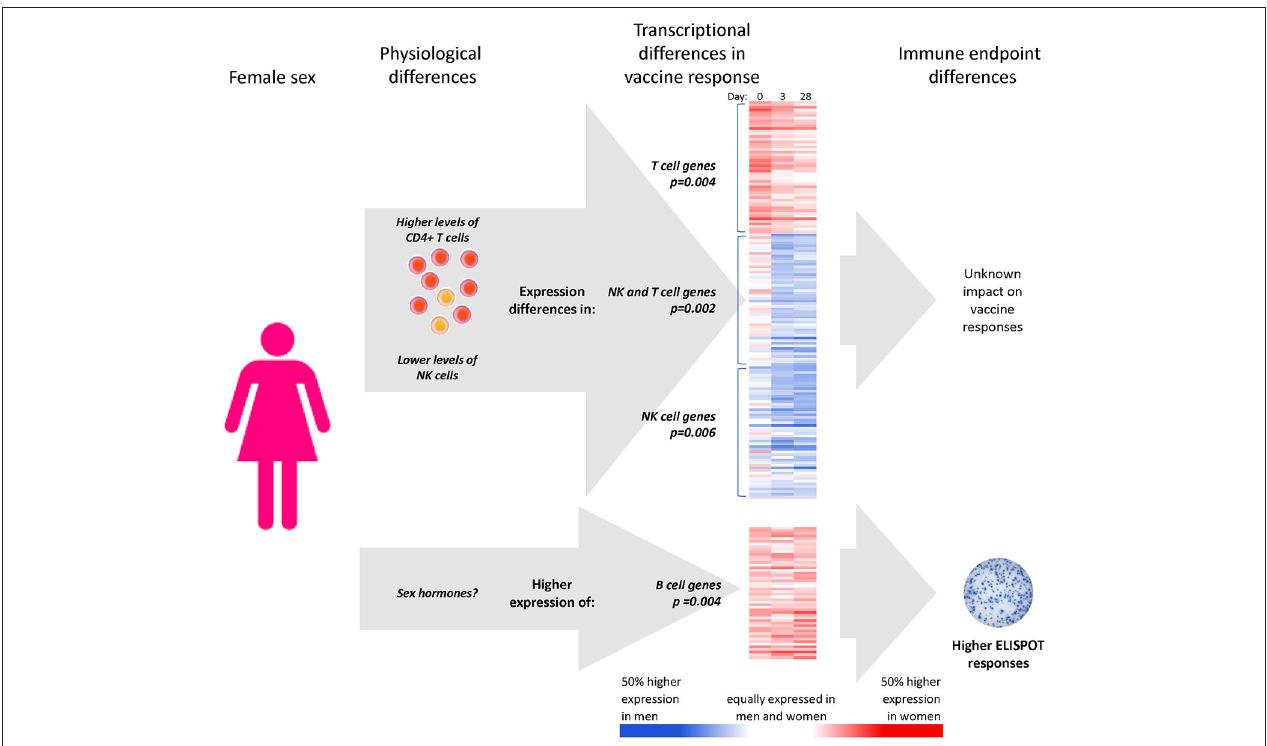
FIGURE 6 | Apparent mechanisms of sex effects on influenza vaccine responses. CD4 + T cell and NK cell numbers mediate part of the effect of subject sex on the expression levels of gene clusters involved in NK cell and T cell genes, with unknown impact on immune outcomes. Higher expression of 135 B cell genes in females was not found to relate to sex differences in immune cells; however, it was determined that these B cell genes were, however, statistical mediators of the higher B-cell ELISPOT responses to seasonal influenza vaccine found in females relative to males. *Gene expression heatmaps present the sex-differential expression of the 50 most representative genes of each sex-dependent gene cluster (i.e., most highly correlated with the cluster